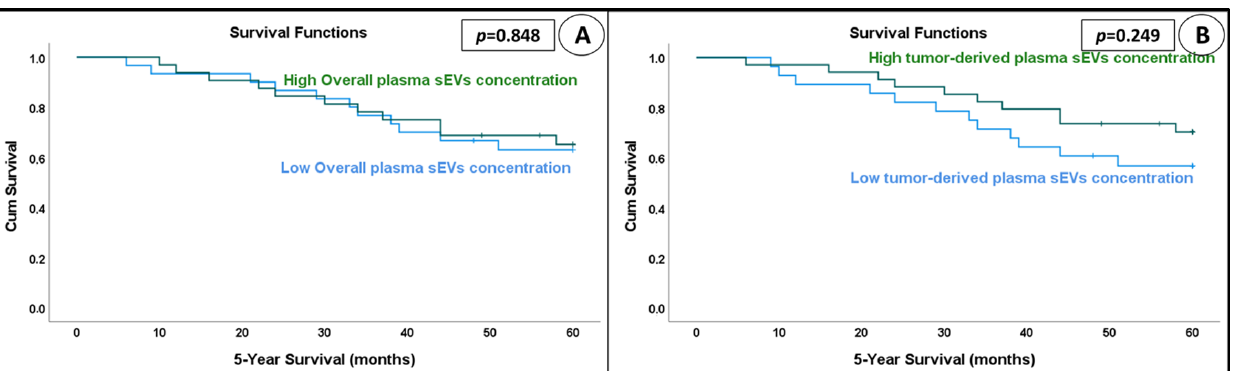
Figure 6. Overall plasma sEVs concentration in healthy controls (n = 39), patients with adenomas (n = 39) and patients with CRC (n = 65) ( A ), overall plasma sEVs concentration in patients with CRC before surgery (n = 65), before (n = 7) and post systematic treatment (n = 5) ( B ) and tumor-derived plasma sEVs concentration in patients with CRC before surgery (n = 65), before (n = 7) and post systematic treatment (n = 5) ( C ).